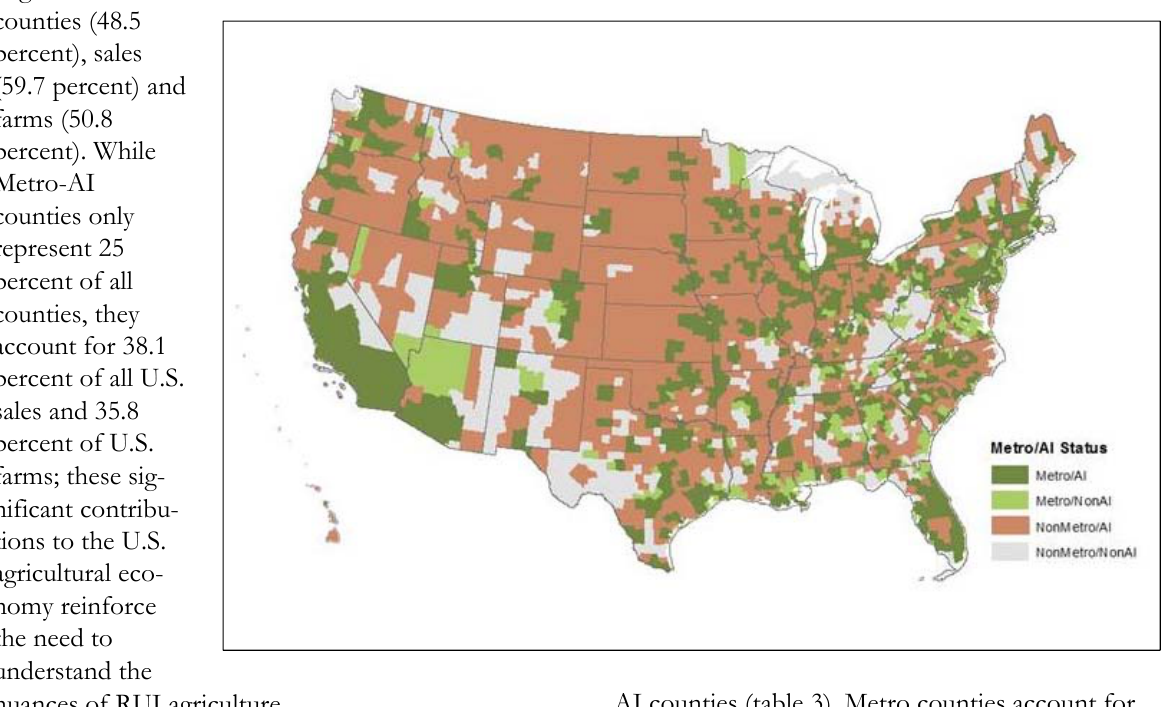
Figure 1. Spatial Distribution of the Metro/Nonmetro and AI/Non-AI Counties,